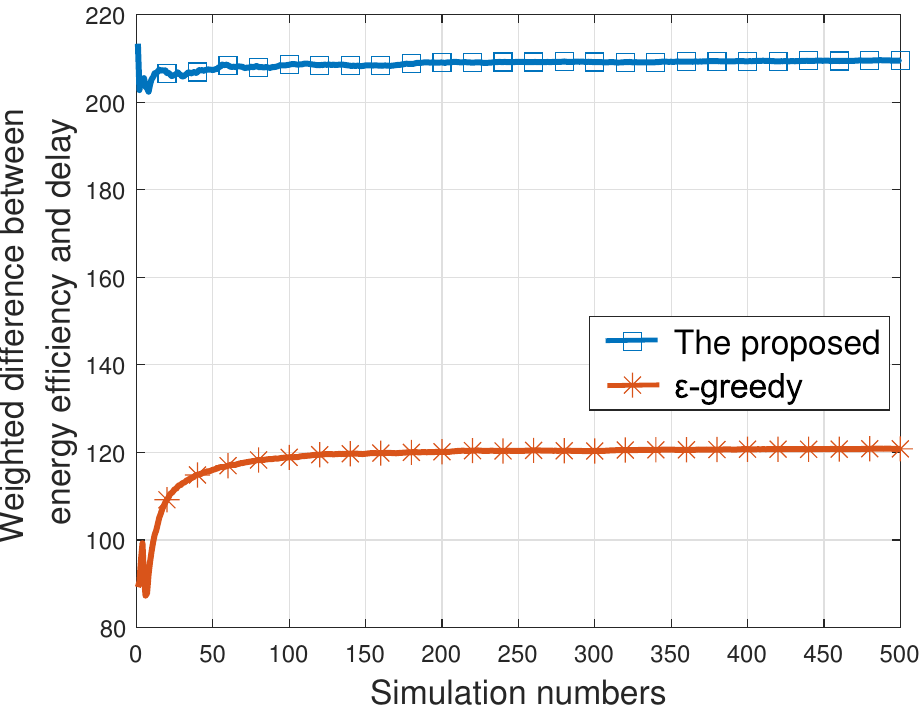
Figure 10. Weighted difference between energy efficiency and delay versus simulation numbers.